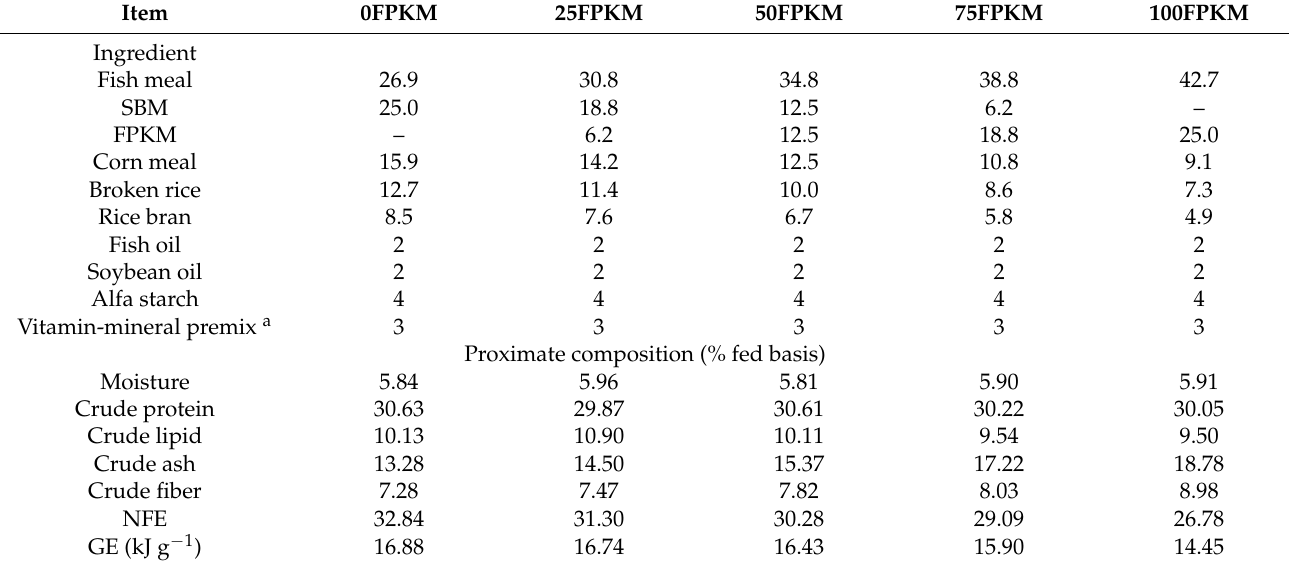
Table 1. Formulations and proximate compositions of experimental diets containing varying levels of